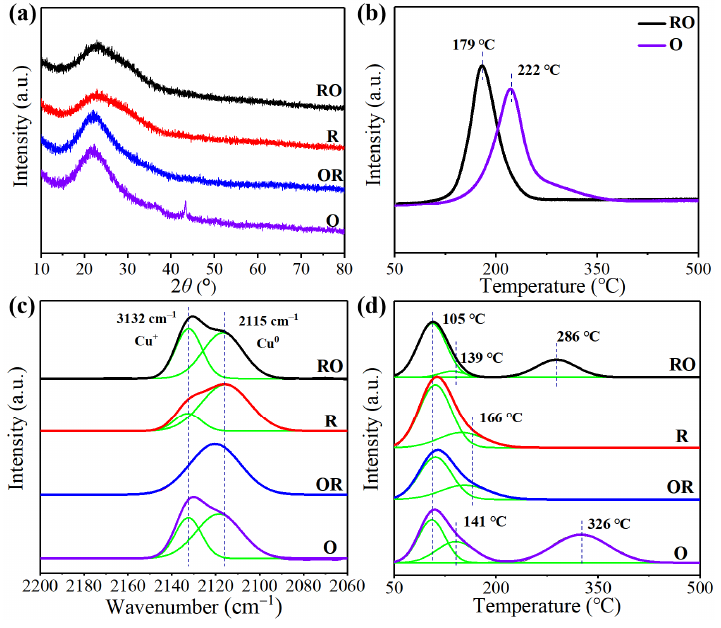
Figure 7. ( a ) Wide-angle XRD patterns, and ( b ) H 2 -TPR analysis, of the Cu/KIT-6 catalyst under different treatment atmospheres. ( c ) In situ DRIFTS analysis of sequential adsorbed CO over the Cu/KIT-6 catalyst, and ( d ) NH 3 -TPD analysis of the Cu/KIT-6 catalyst, under different treatment